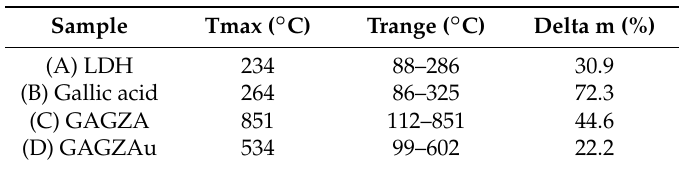
Table 2. Maximum peak temperature (Tmax) decomposition temperature range (Trange) and change in mass (Delta m).